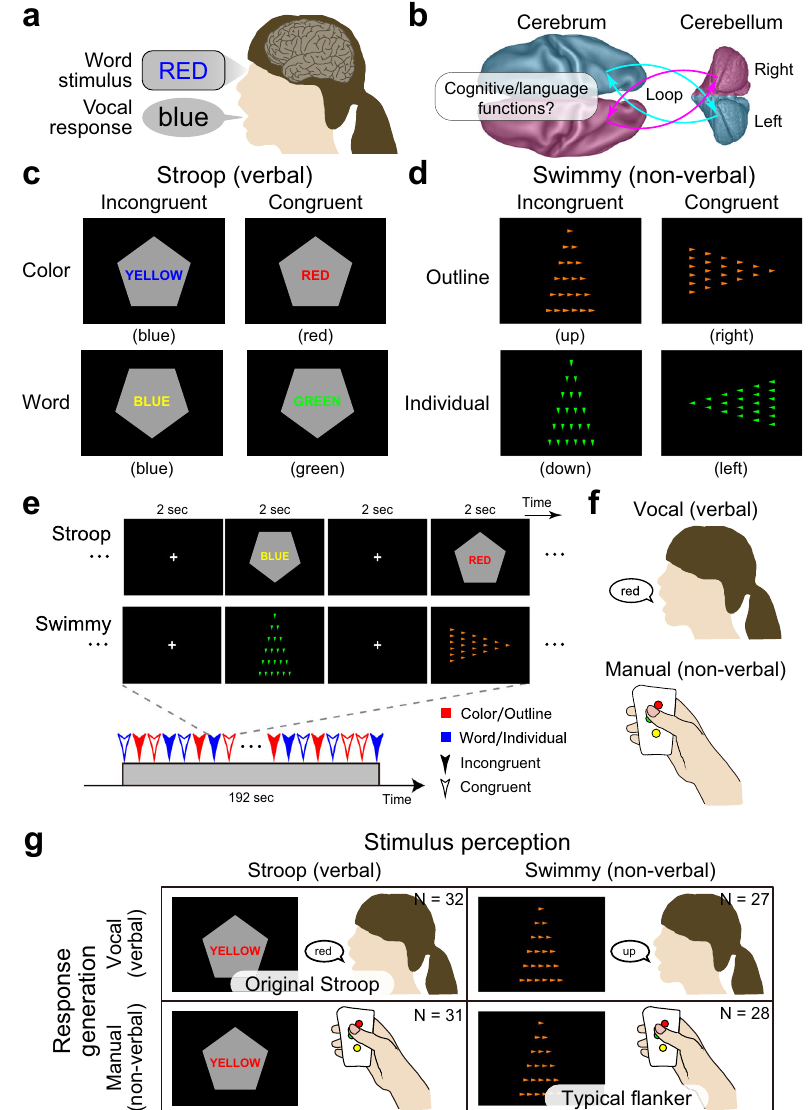
Fig. 1 | Experimental design to examine the role of language processing in the resolution of the Stroop effect. a Stroop effect. It takes longer to name the color of a colored wordwhen the word is colored in aninconsistentcolor (e.g., the word “ RED ” in blue-color font). b A schematic illustration of cross-hemispheric cerebro- cerebellarloops. c Strooptasks. Participants made a judgment regarding the color (top) or word (bottom) of a colored word (Stroop task). The judgment was indi- cated by the orientation of the vertex of a pentagon (up: color; down: word). The word color and colored word were inconsistent (incongruent; left) or consistent (congruent; right). d Control (Swimmy) tasks. Another set of participants made a